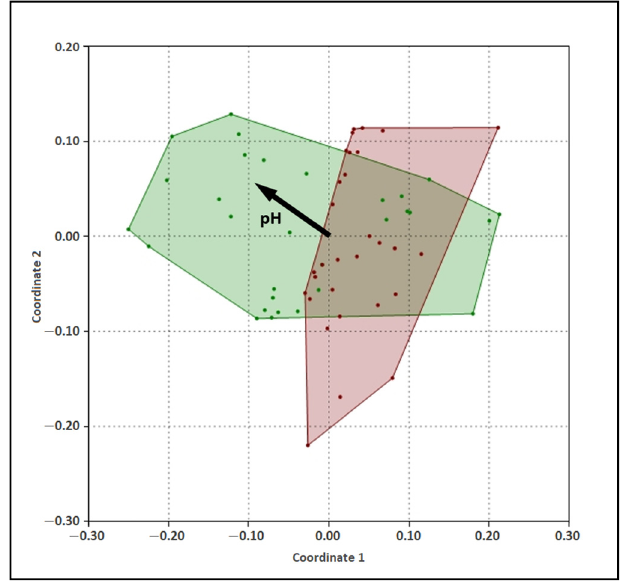
Figure 4. Non-metric multidimensional scaling (NMDS) plots based on the Jaccard similarity index of ECM fungal symbionts associated with Carya (green) and Q. rubra (red).